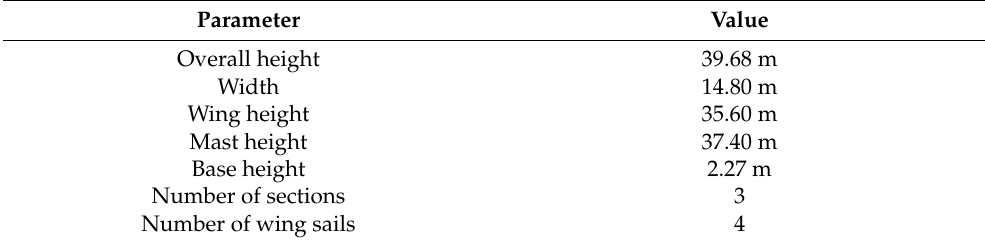
Table 4. Parameters of wing